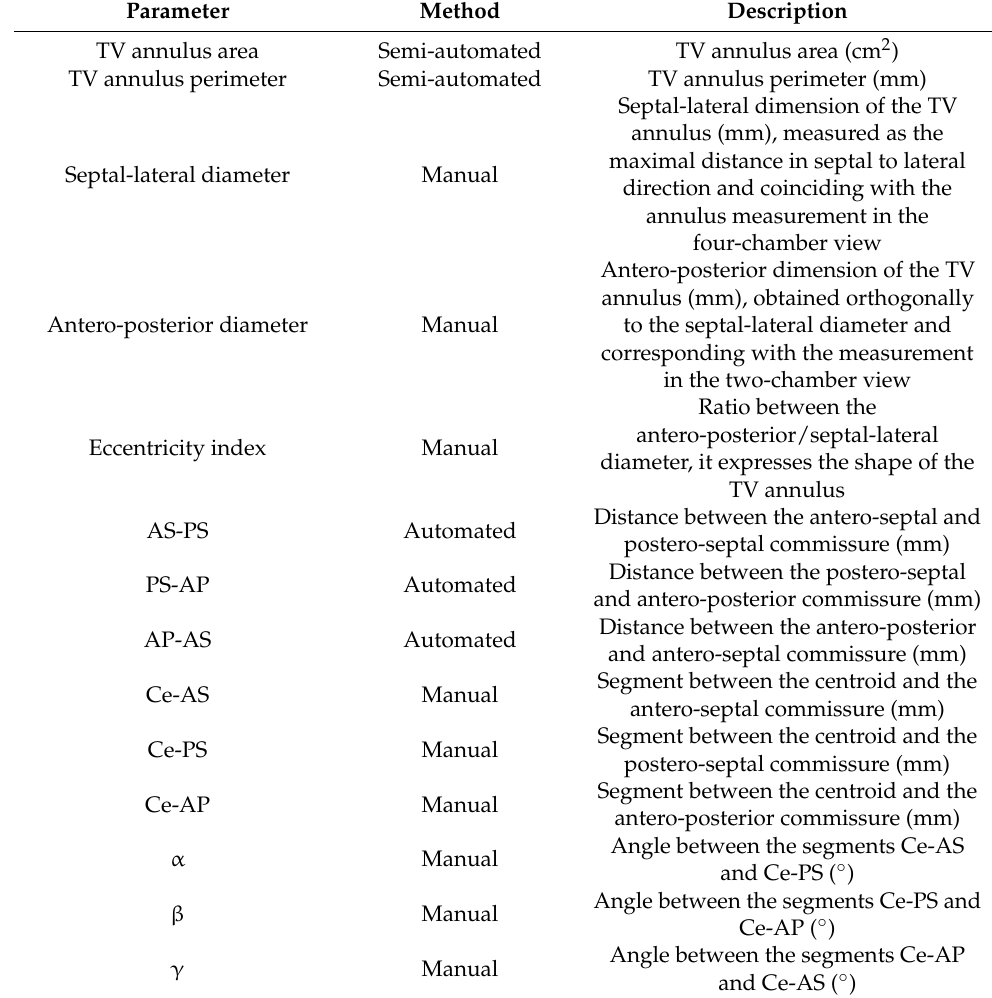
Table 1. Overview of the CT scan parameters analyzed offline.